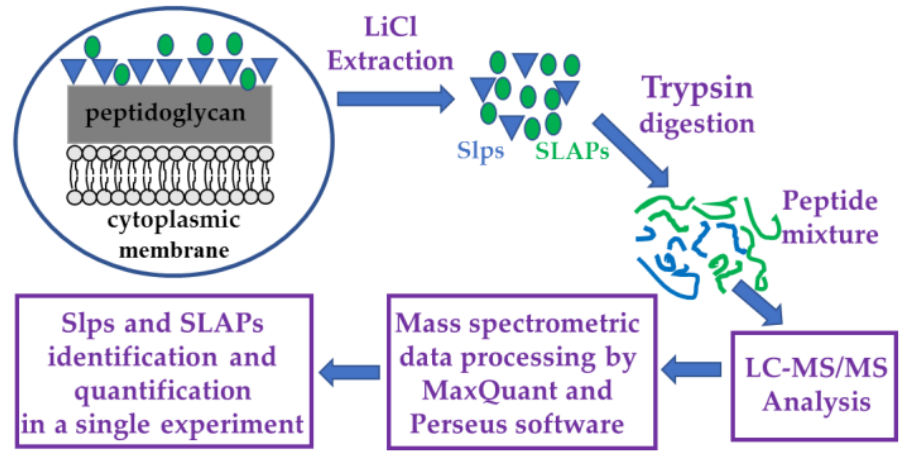
Figure 1. Flow chart of the experimental design. Surface layer proteins (Slps) are indicated with blue triangles and surface layer associated proteins (SLAPs) with green circles.